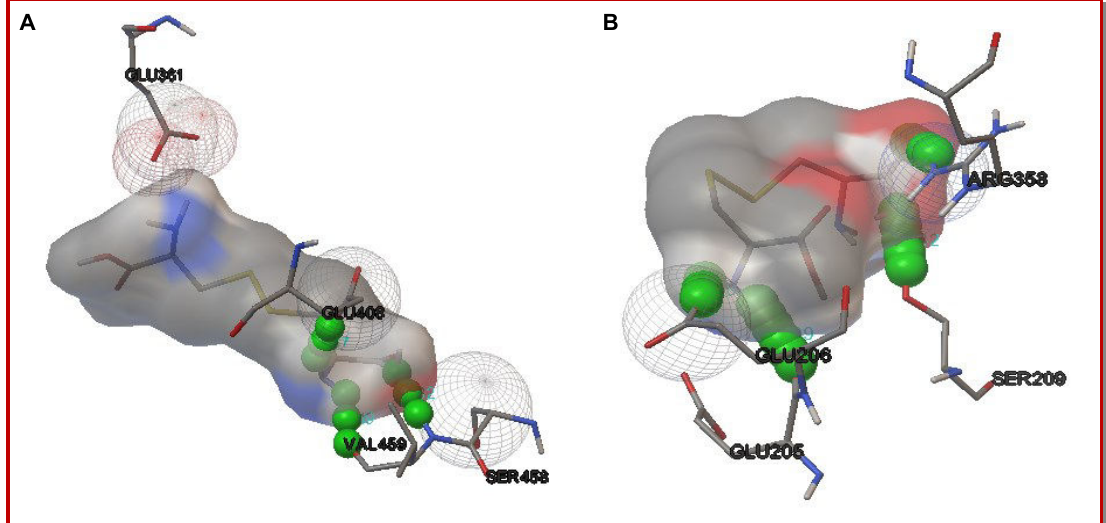
Figure 4: Inhibitory action of cystine with DPP-IV using AutoDock hydrogen bond interaction A) A chain B) B chain